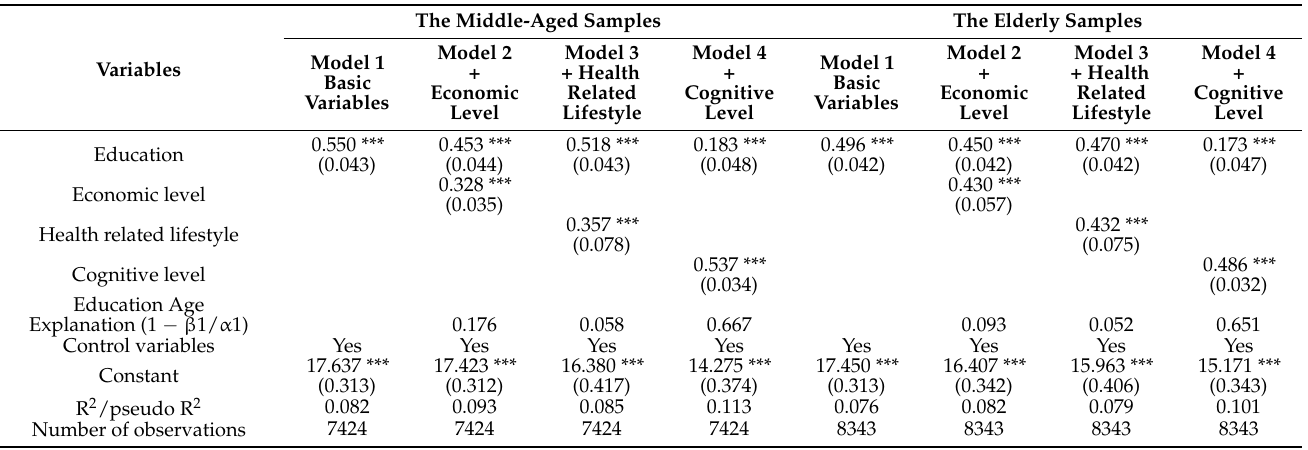
Table 5. Results of multiple regression analysis and mediation effect analysis of middle-aged samples and elderly samples,